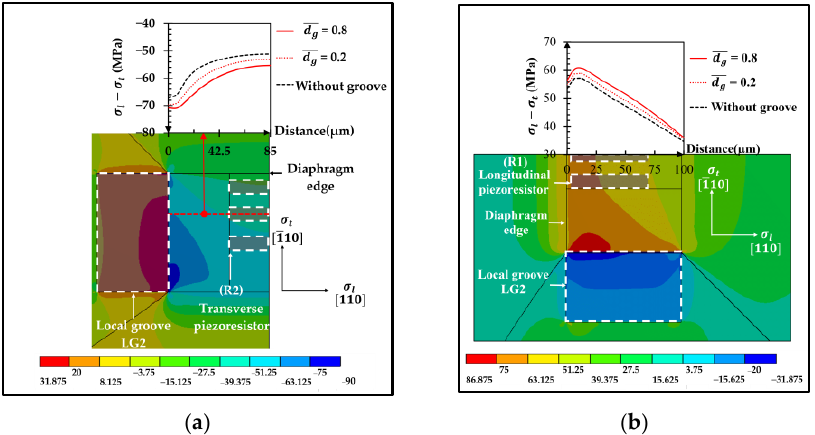
Figure 10. Stress difference distributions at the applied pressure of 5 kPa: ( a ) transverse piezoresistor and ( b ) longitudinal piezoresistor for 𝐿𝐺2 − 𝐿𝑇 − 𝑇𝑜𝑝 ( 𝑑 𝑔 ̅̅̅ = 0.8). (Only one-half of the domain is displayed.)